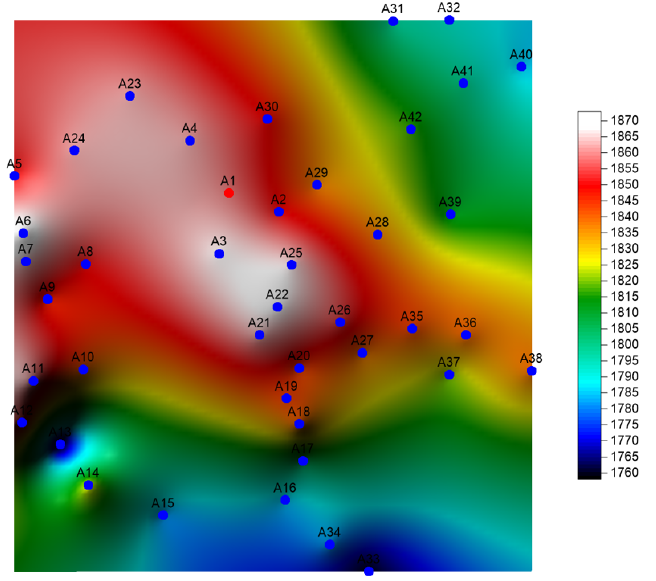
Figure 11. Distribution of wind turbines used for real-time study. The color shades show the terrain height (meters above sea level).